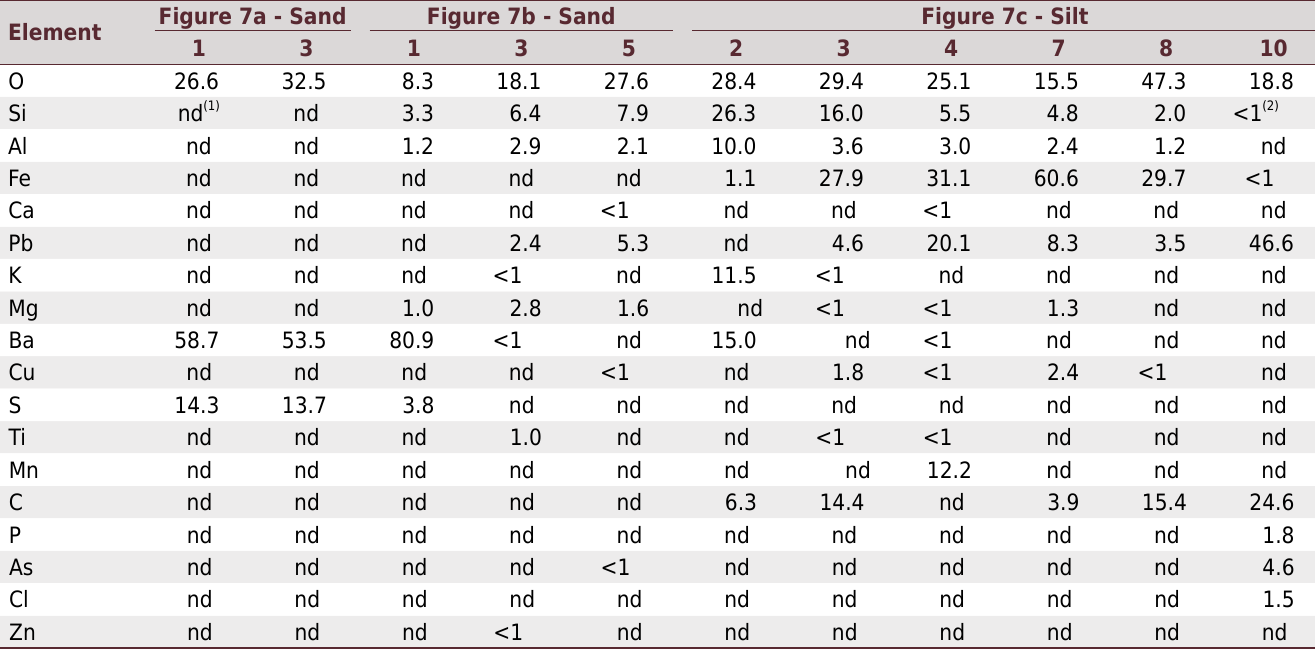
Table 5. Chemical analysis (% - m/m) of sample 23 for selected particles identified in figure 7 Figure 7a - Sand Figure 7b - Sand Figure 7c - Element